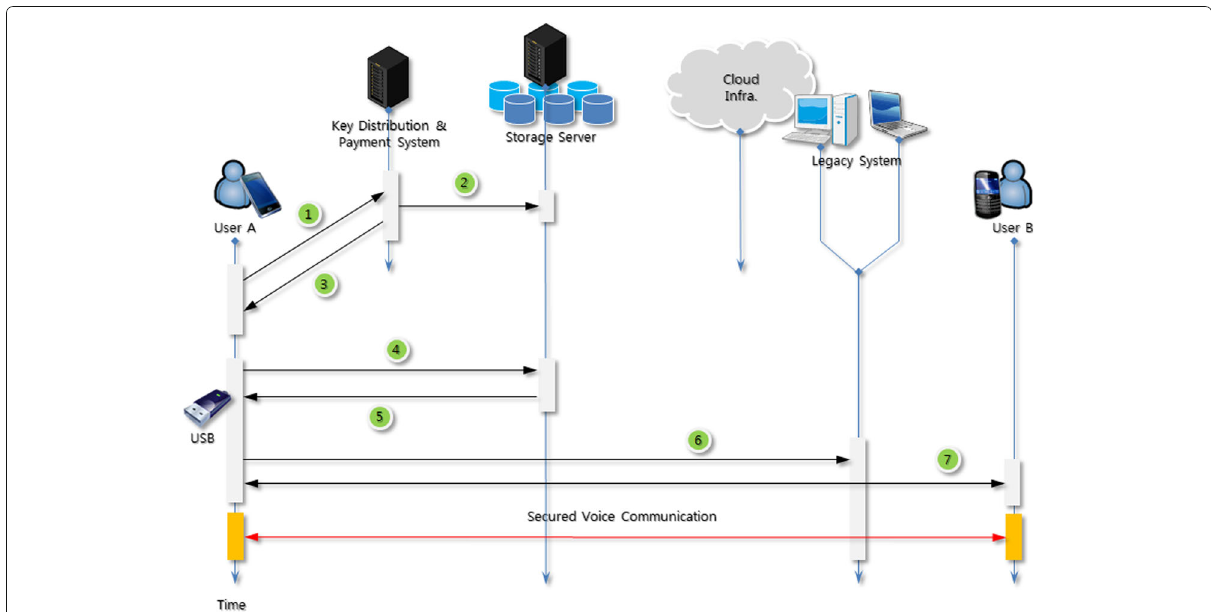
Fig. 4 Concept diagram of the registration and deployment of a secure mVoIP service